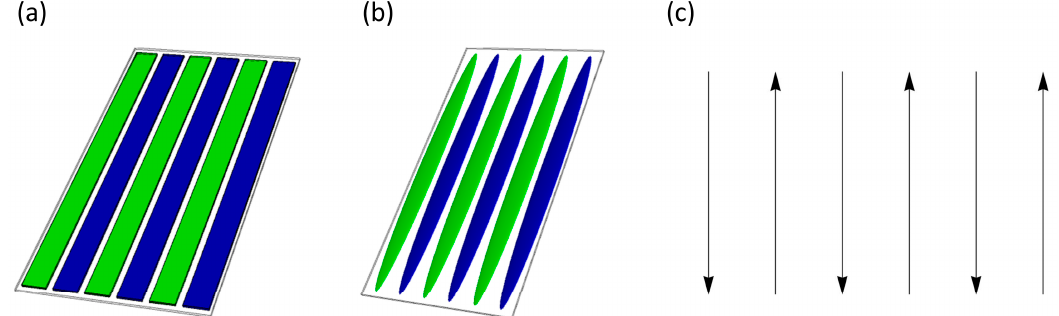
Figure 1. Schematic of the models used: ( a ) stripes, ( b ) ellipsoids and ( c ) S-W discrete approximation. Green and blue colors in ( a , b ) correspond to the magnetization upwards and downwards, respectively.